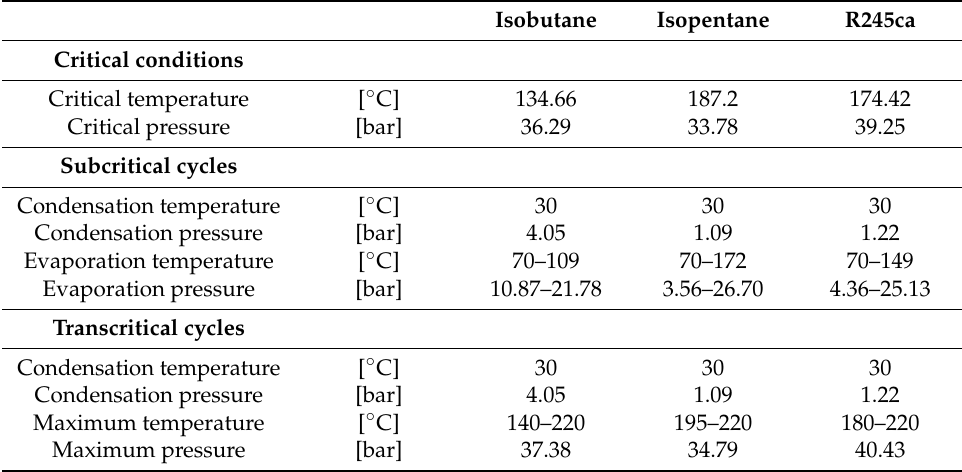
Table 1. Critical conditions of selected organic fluids and ORC operating conditions.